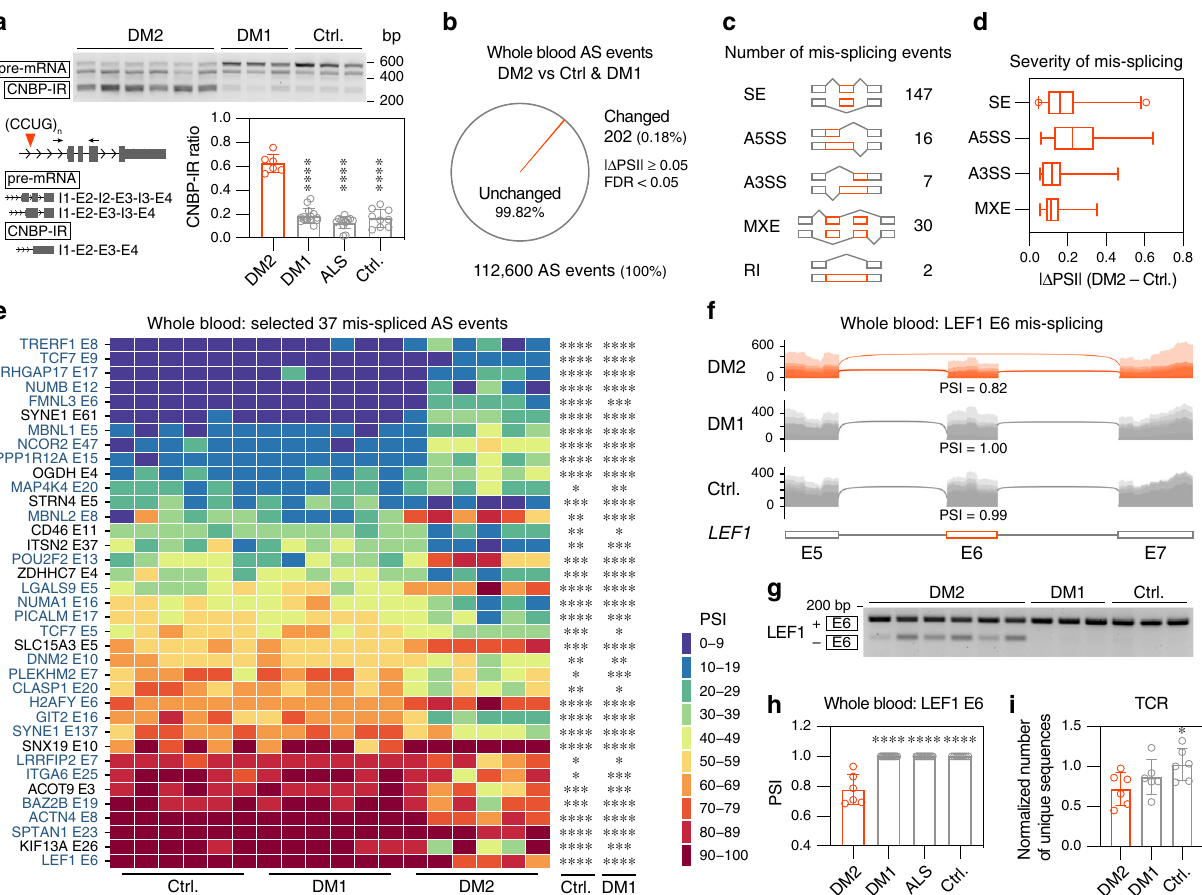
Fig. 5 Alternative splicing changes in DM2 whole blood. a RT-PCR analysis of CNBP-IR in DM2 ( n = 6), DM1 ( n = 19), ALS = ( n = 13) and unaffected control ( n = 11) whole blood samples. Bar graph shows mean CNBP intron 1 retention ratio ± SD. Signi fi cant difference was determined by Dunnett ’ s multiple comparisons test: **** P adj < 0.0001. b Pie chart represents all detected AS events in whole blood RNA-seq. Orange triangle represents signi fi cantly changed AS events in DM2 ( n = 6) compared to DM1 ( n = 6) and unaffected ( n = 6) controls. c Number of signi fi cantly changed AS events assigned to different categories. d Box plot of AS event| Δ PSI | values. Center line represents the median, and the box extends from the 25th to 75th percentiles. Whiskers show 1-99 percentile. e Heat map shows selected 37 AS events changed in DM2 compared to both DM1 and unaffected controls. Note that TCF7 E9 is the mouse Tcf7 E10 ortholog. * FDR < 0.05, ** FDR < 0.01, *** FDR < 0.001, **** FDR < 0.0001. f Sashimi plot with mean PSI values for LEF1 E6 in DM2 ( n = 6), DM1 ( n = 6) and unaffected control (n = 6) RNA-seq samples. g Representative RT-PCR assay gel of LEF1 E6 from DM2, DM1 and unaffected control (Ctrl.) whole blood samples. h Aberrant LEF1 E6 exclusion in a large cohort of DM2 ( n = 6), DM1 ( n = 19), ALS ( n = 13) and unaffected ( n = 11) control whole blood samples. Signi fi cant difference was determined by Dunnett ’ s multiple comparisons test: **** P adj < 0.0001 i Reduction of TCR repertoire detected in DM2 whole blood RNA-seq. Bar graph shows the total number of TRB and TRA clones normalized to uniquely mapped reads ± SD. Signi fi cant difference was determined by Dunnett ’ s multiple comparison test: * P adj = 0.042. Source data are provided as the Supplementary Data 1 and Source Data fi